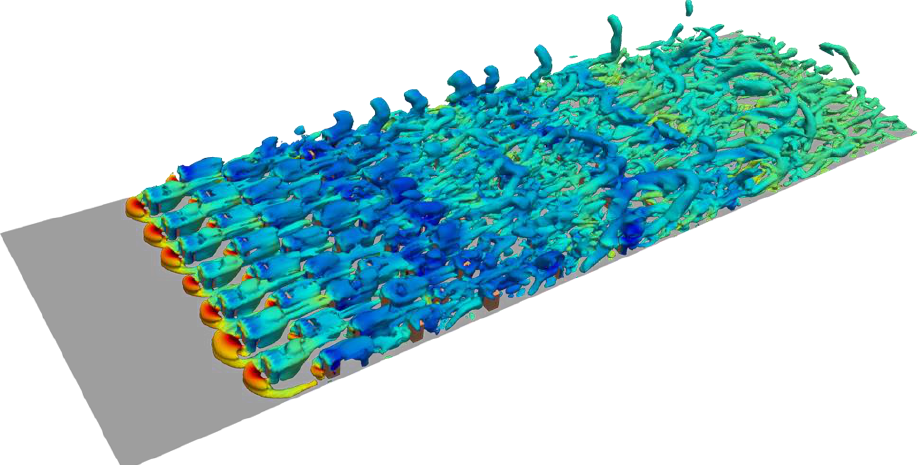
profiles of streamwise velocity ( b ) the profiles of crosswise velocity ( c ) the profiles of vertical velocity.